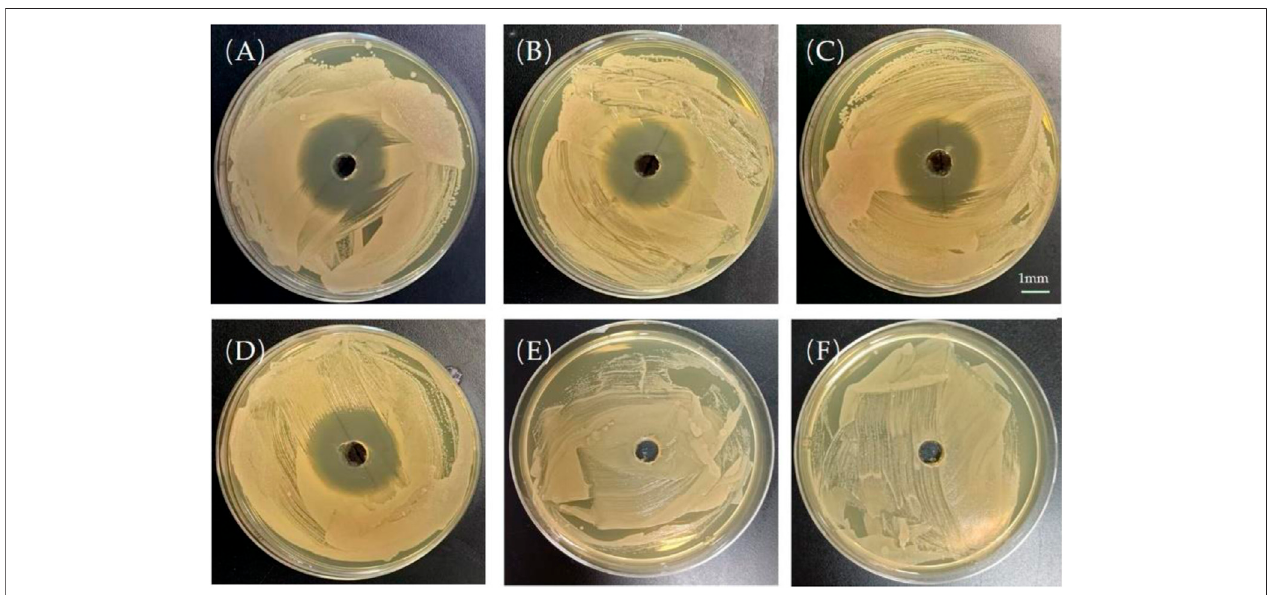
FIGURE 5 | Bacteriostatic rings produced by the release solution of the cipro fl oxacin-loaded PTMC implants at day 1 (A) , day 7 (B) , day 14 (C) , day 28 (D) ; Bacteriostatic rings produced by the leaching solution of blank PTMC at day 1 (E) and day 7 (F) . The scale bar is 1 mm.